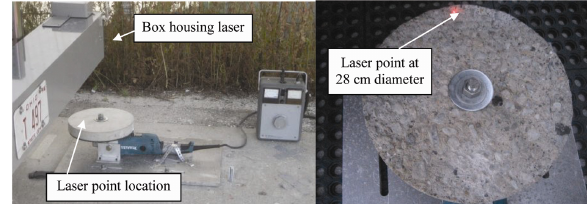
Fig. 4. Test apparatus for laser profiler